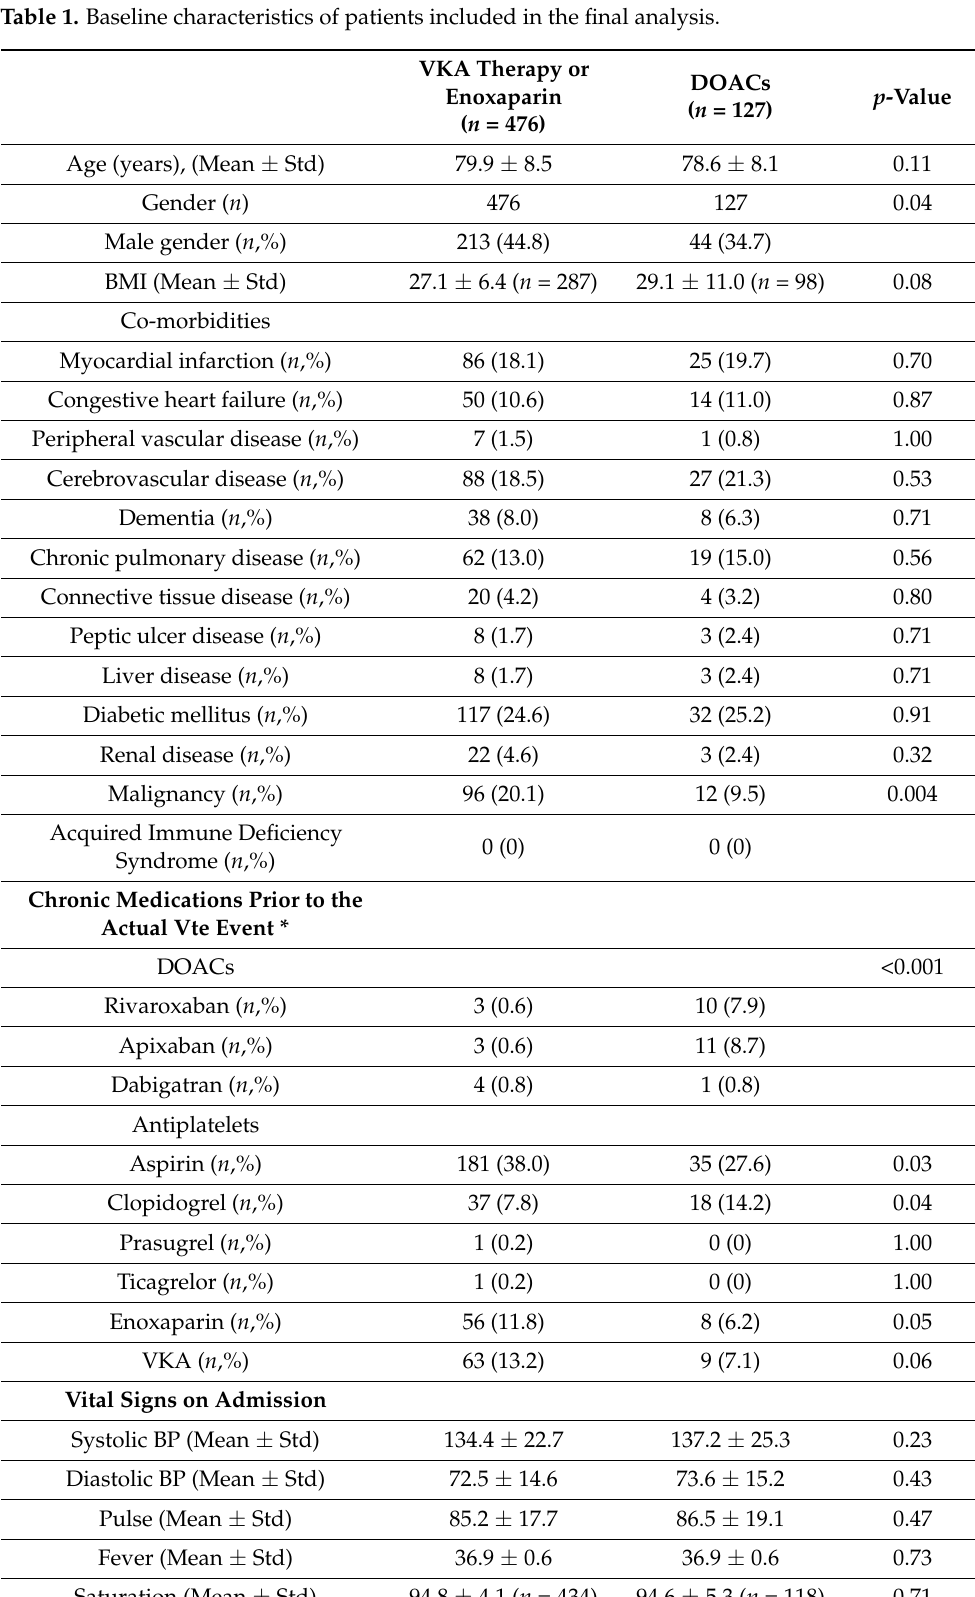
Table 1. Baseline characteristics of patients included in the final